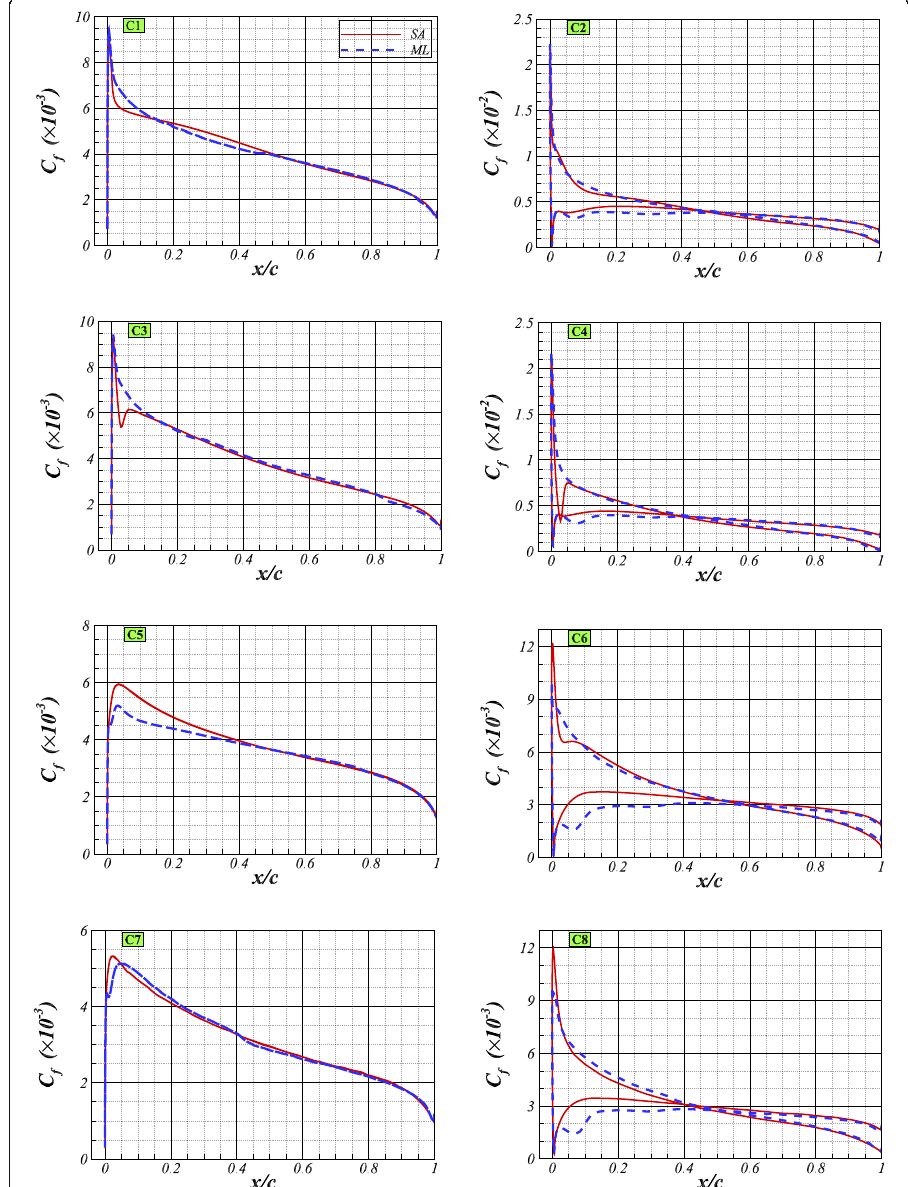
Fig. 15 The C f comparison of the eight boundary point cases of NACA0012